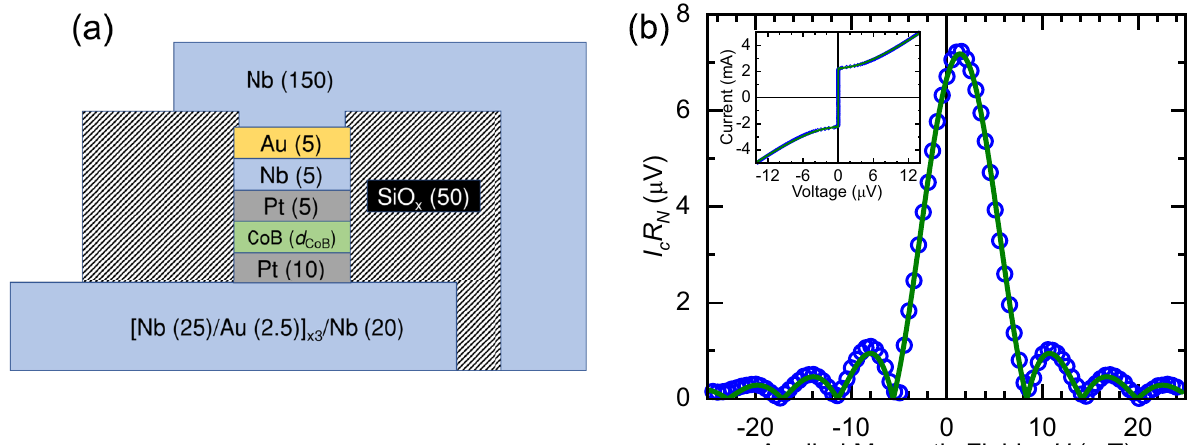
Figure 2. ( a ) Schematic cross section of the S - F - S Josephson junction device (not to scale). The thickness of each layer is given in nanometers. The Co 68 B 32 layer thickness, d CoB , is ranged from 0.2 to 1.4 nm. ( b ) Product of critical Josephson current times normal-state resistance versus applied magnetic field for the device depicted in ( a ) with d CoB = 0.6 nm at 1.8 K. I c is determined from the measured I – V characteristic at each field value and R N is the average normal state resistance across all measured fields. The uncertainty in determining I c R N is smaller than the data points. The data are fit with Eqs. (2) and (3). Inset: The I – V characteristic at zero applied field with fit to Eq.